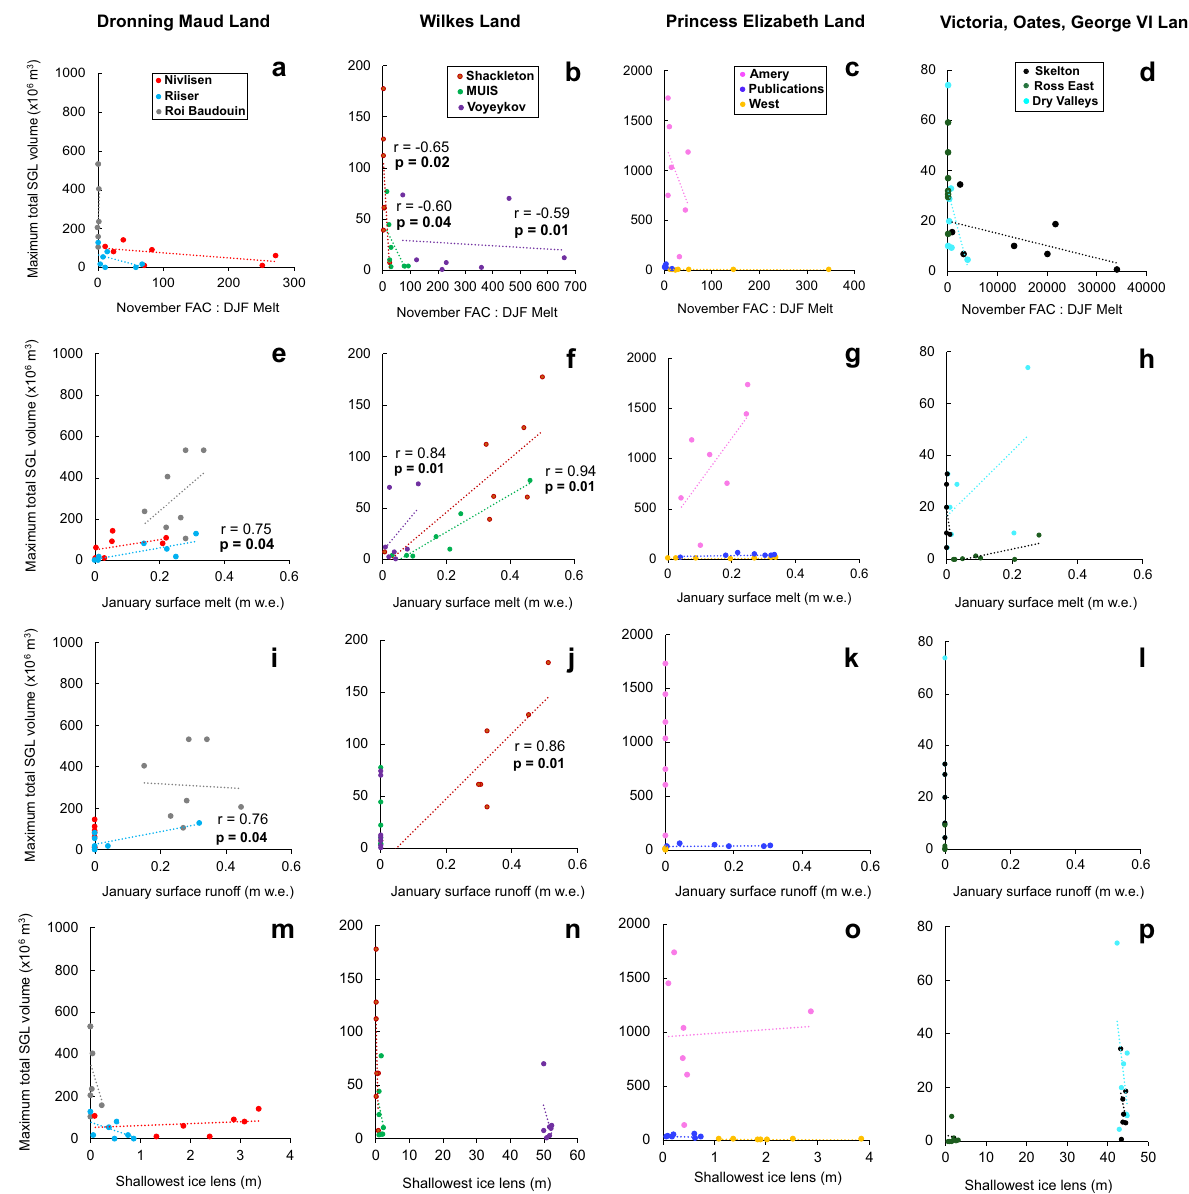
Fig. 6 Relationships between near-surface conditions and supraglacial lake volumes on the East Antarctic Ice Sheet. Scatter plots of mean November fi rn air content-to-DJF melt ( a – d ), mean January surface runoff ( i – l ) and depth of shallowest ice lens ( m – p ) (simulated by the Community Firn Model) and mean January total surface melt ( e – h ) (simulated by MAR) against maximum total SGL volume, grouped by major EAIS region. Individual ice shelves are represented by different colours (see Fig. 1 for locations). Signi fi cant relationships ( p < 0.05) in a linear regression are